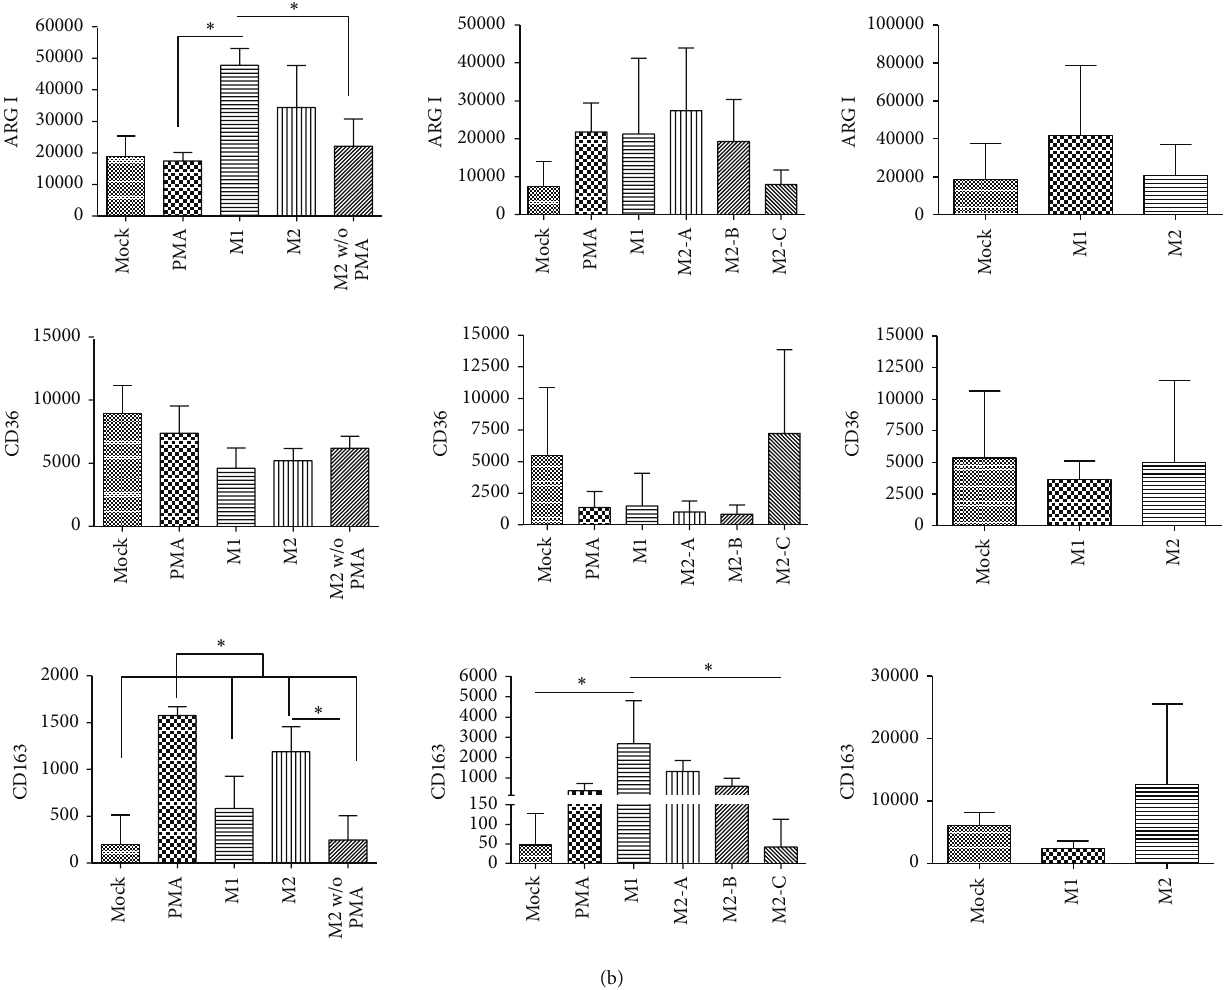
Figure 3: Characterization of M1- and M2-related phenotypes. Median fluorescence intensity corresponding to (a) M1-related markers TNF- 𝛼 , IDO enzyme, CCR7, and CD86 and (b) M2-related markers IL-10, arginase I, CD36, and CD163, found in cells harvested from all different polarizing treatments and controls and analyzed by flow cytometry. For THP-1, mock: no stimulated cells; PMA: PMA-only control; M1: PMA + LPS + INF- 𝛾 ; M2: PMA + IL-4 + IL-13; and M2 w/o PMA: IL-4 + IL-13. For U937, mock: no stimulated cells; PMA: PMA-only control; M1: PMA + LPS + INF- 𝛾 ; M2-A: PMA + IL-4 + IL-13; M2-B: PMA + M-CSF; and M2-C: IL-4 + IL-13. For primary monocytes, mock: no stimulated cells; M1: GM-CSF + LPS + INF- 𝛾 ; and M2: M-CSF + IL-4 + IL-13. Asterisks and bars denote statistical significance between conditions. Significant differences ( 𝑝 ≤ 0.05 ) found were as follows: in THP-1 cells CD86, M1 versus M2; IL-10, mock versus all the rest of the conditions; arginase I, M1 versus PMA and versus M2 without PMA; CD163, PMA versus all the rest of the conditions and M2 versus M2 without PMA. In U937 cells IDO, M2-A versus mock and versus M2-C; CD86, (PMA, M1, M2-A, and M2-B) versus mock and M2-C; CD163, M1 versus mock and versus M2-C. In primary monocytes IDO and CD86 were significantly different in M1 versus mock and versus